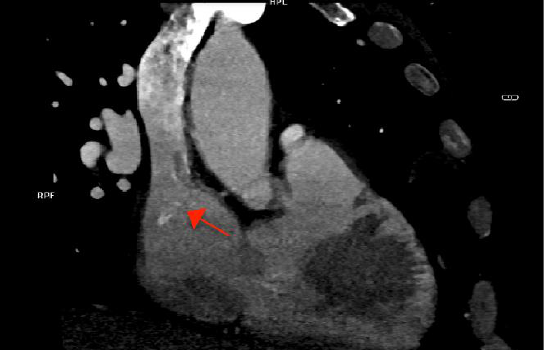
Figure 3. Cardiac computed tomography showing the calcified fibrin sheath in the superior vena cava (arrow), without evidence of vegetations. There was a subacute right occipital stroke and splenomegaly with splenic infarctions, both of which were interpreted as embolic consequences of the IE (Figure 4).